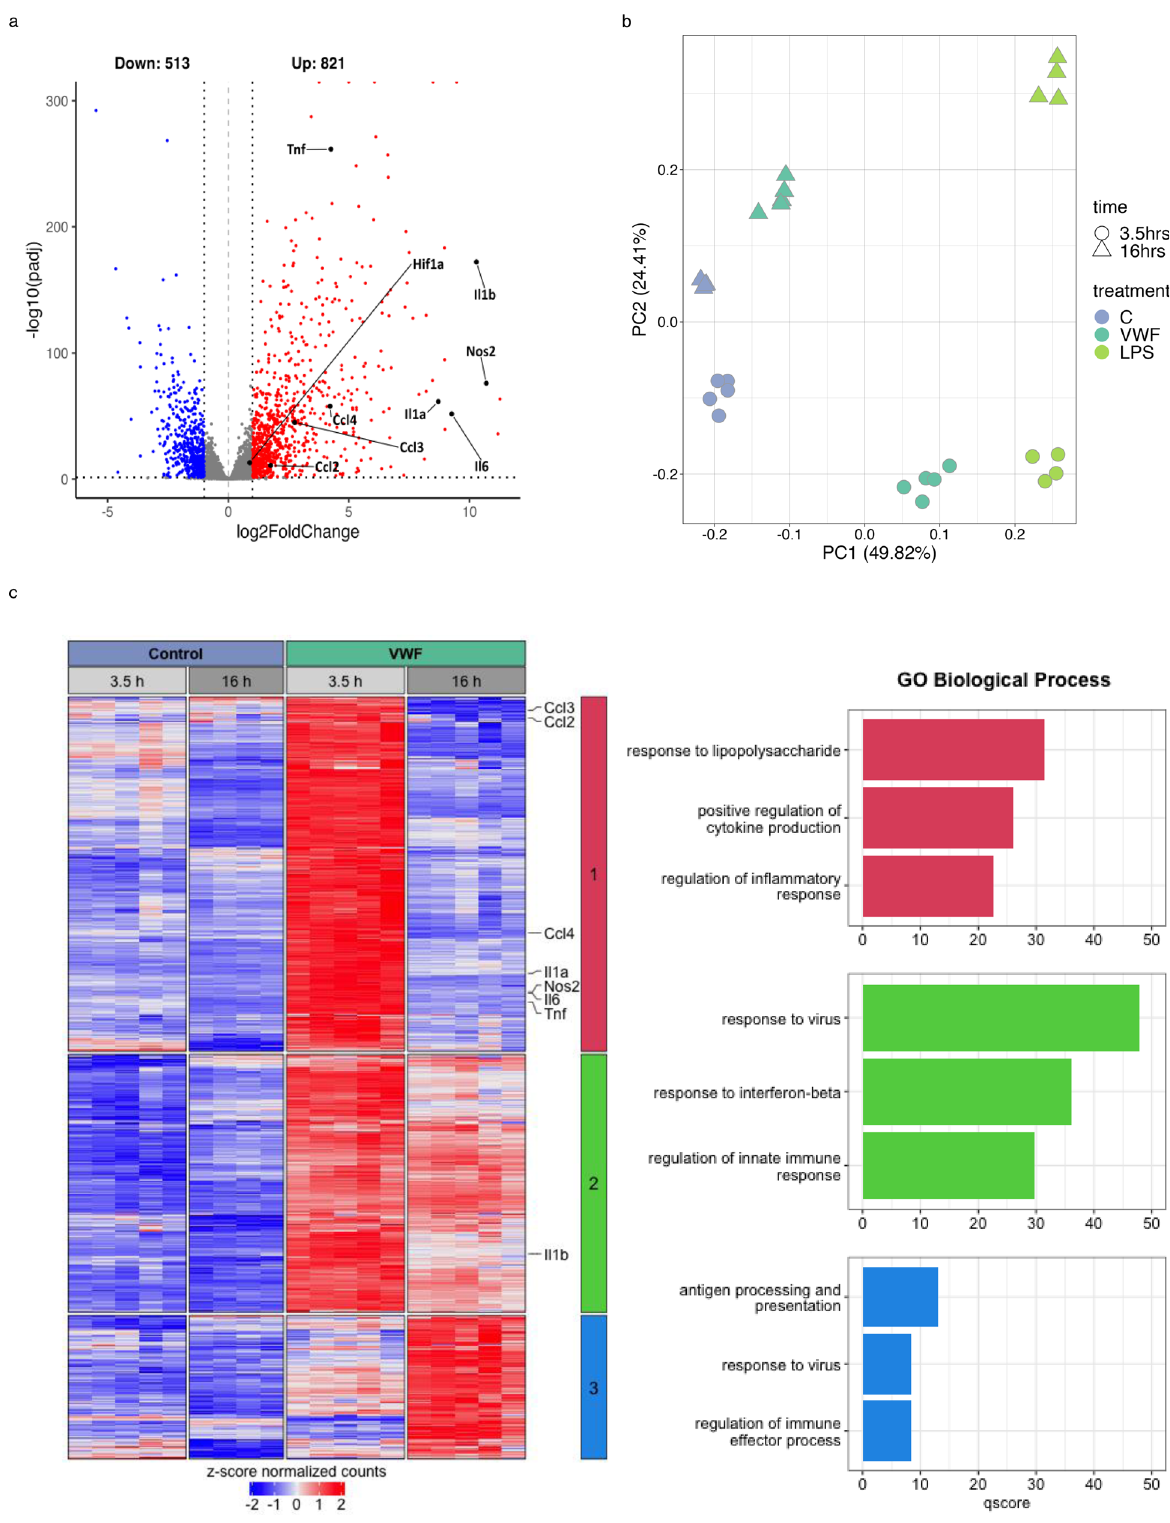
Fig. 2 | VWF induces a pro-in fl ammatory transcriptional response in macro- phages.a Volcanoplotofsigni fi cantlydifferentiallyexpressedgenes(FDR<0.05) as detected by RNAseq in VWF-treated macrophages versus PBS-control for 3.5h ( n =5 each). Red and blue dots indicate statistically signi fi cant up- and down- regulated genes, respectively. Key pro-in fl ammatory genes are labeled in black. b First (PC1) and second (PC2) principle components of a PCA plot of RNA-seq data of control- (blue), VWF-(dark green) and LPS-treated (light green) macro- phages at different time points. c Heatmap of genes that are induced by VWF-